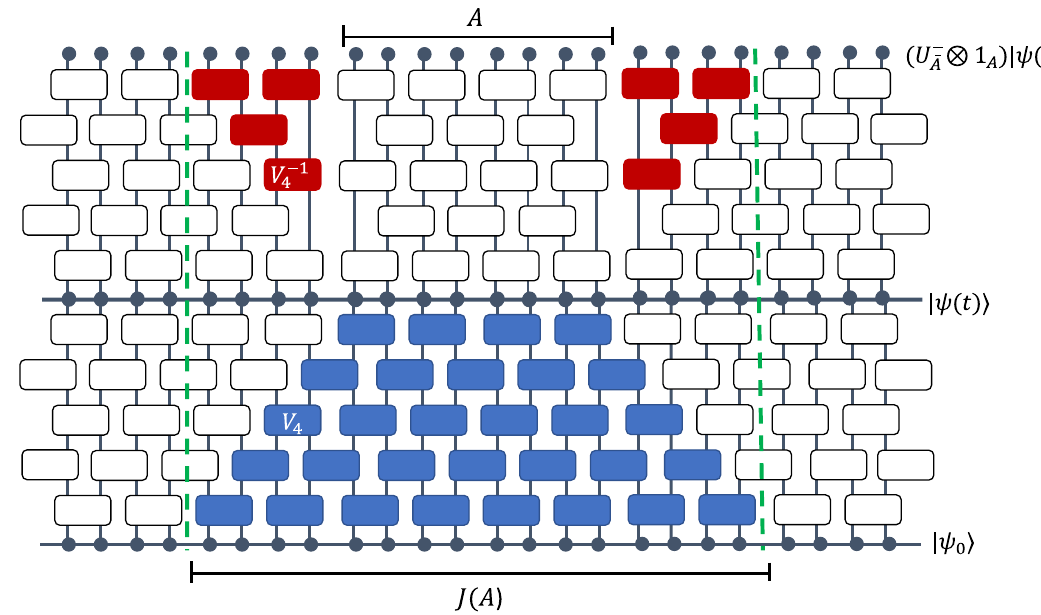
FIG. 18. Due to the cancellation of inverses between local operators in U and U − ¯ the circuit shown above, where the time-evolution operator is of the form ˜ U J ( A ) ⊗ 1 the green dashed